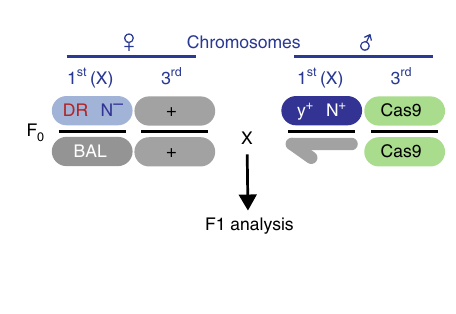
of the DsRed-labeled y <ccN> element onto the y + N + receiver chromosome (29.3% and 31.8% conversion of the receiver chromosome in males and females, respectively), (2) copying of the N Ax16 allele (27% conversion of the receiver chromosome in males), (3) recovery of N − / N + ♀ (12%), and (4) Cas9-dependent depletion of receiver chromosomes in males (40.8% compared to 51.1% in control animals). Each of these measures of residual drive observed in the F3 generation (Fig. 3b), which we refer to as shadow-drive, was considerable, amounting to roughly half of that observed in the prior F2